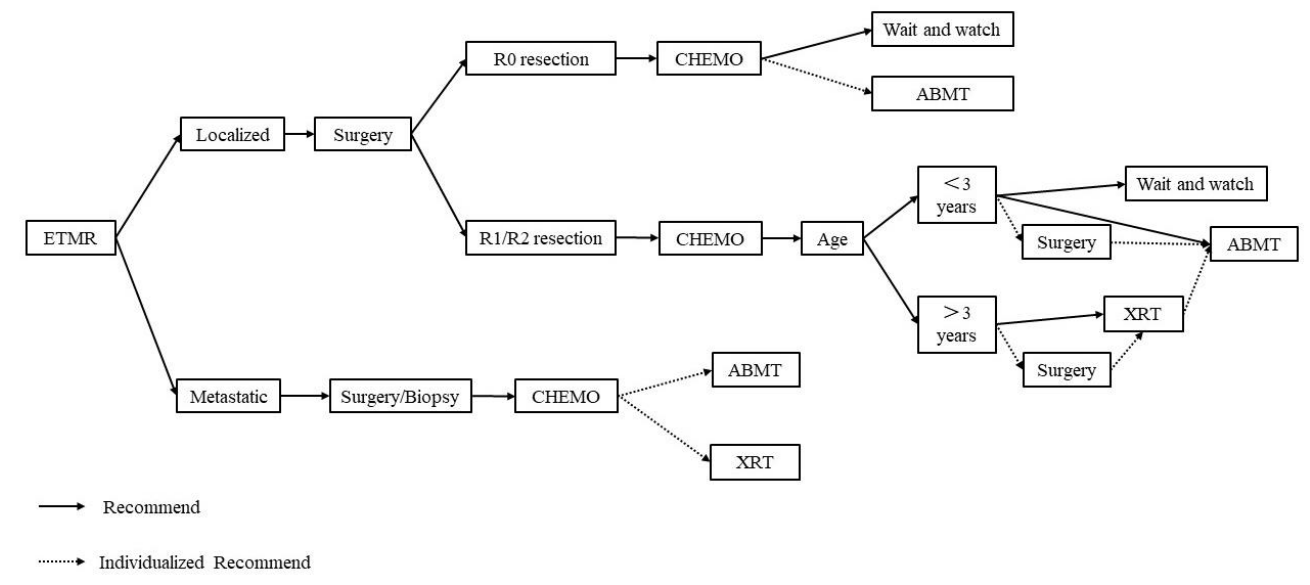
Figure 1. The treatment strategy for